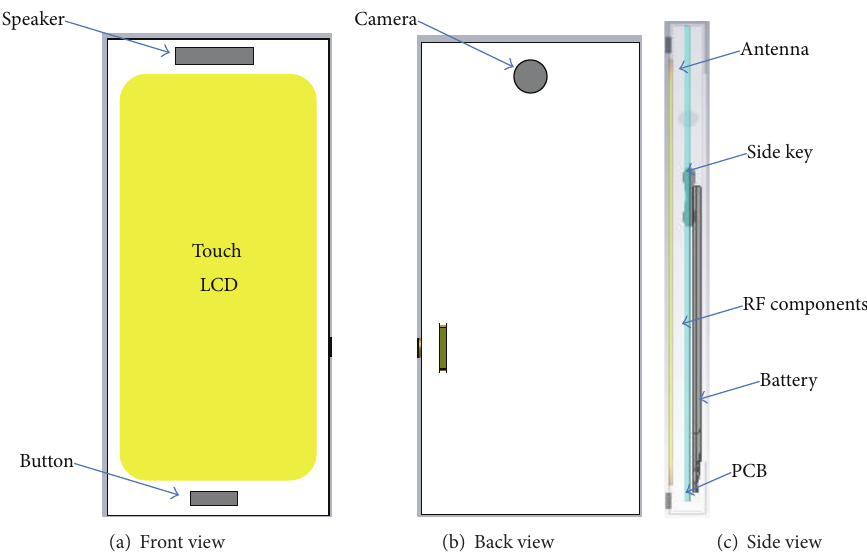
Figure 7: Structure of mobile handset: (a) front, (b) back, and (c) side view.